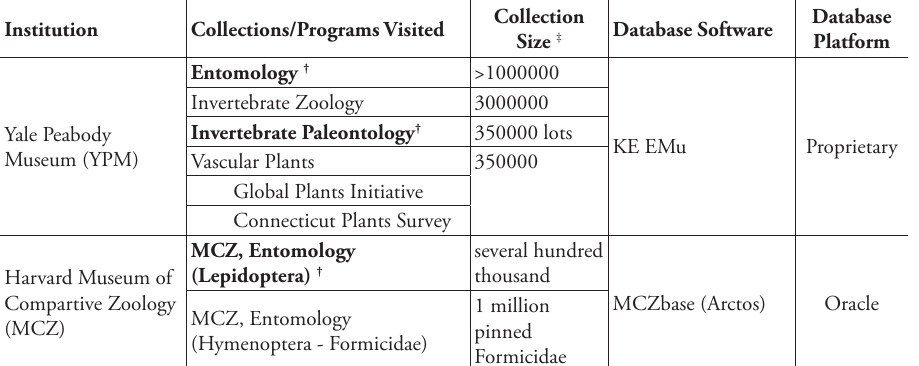
table 1. Summary List of Collections